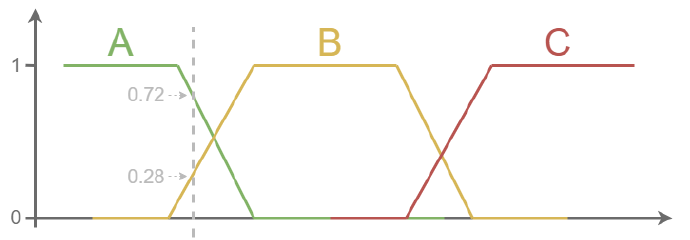
Figure 7. Representation of the fuzzy logic